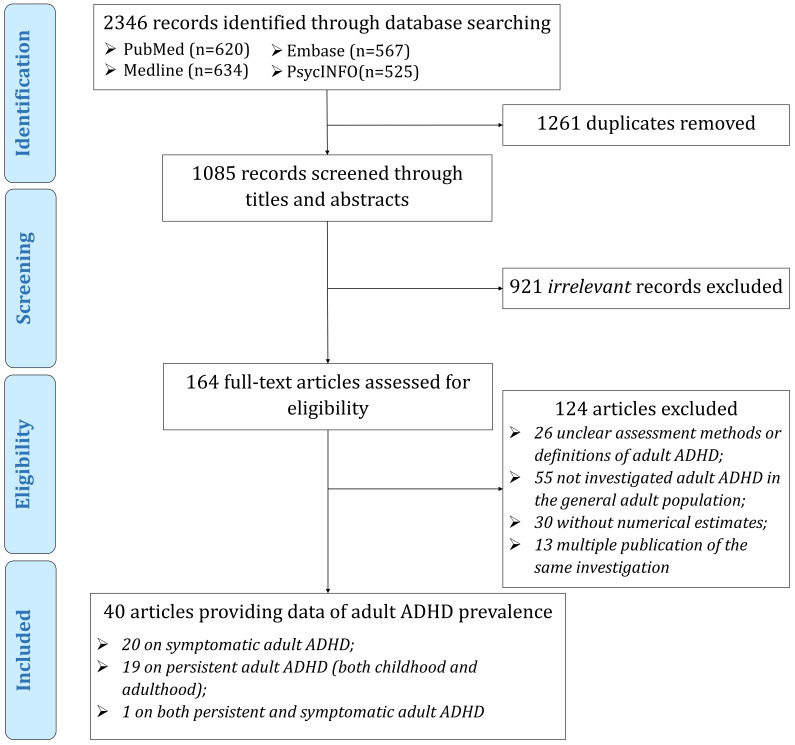
PRISMA flowchart of study selection.